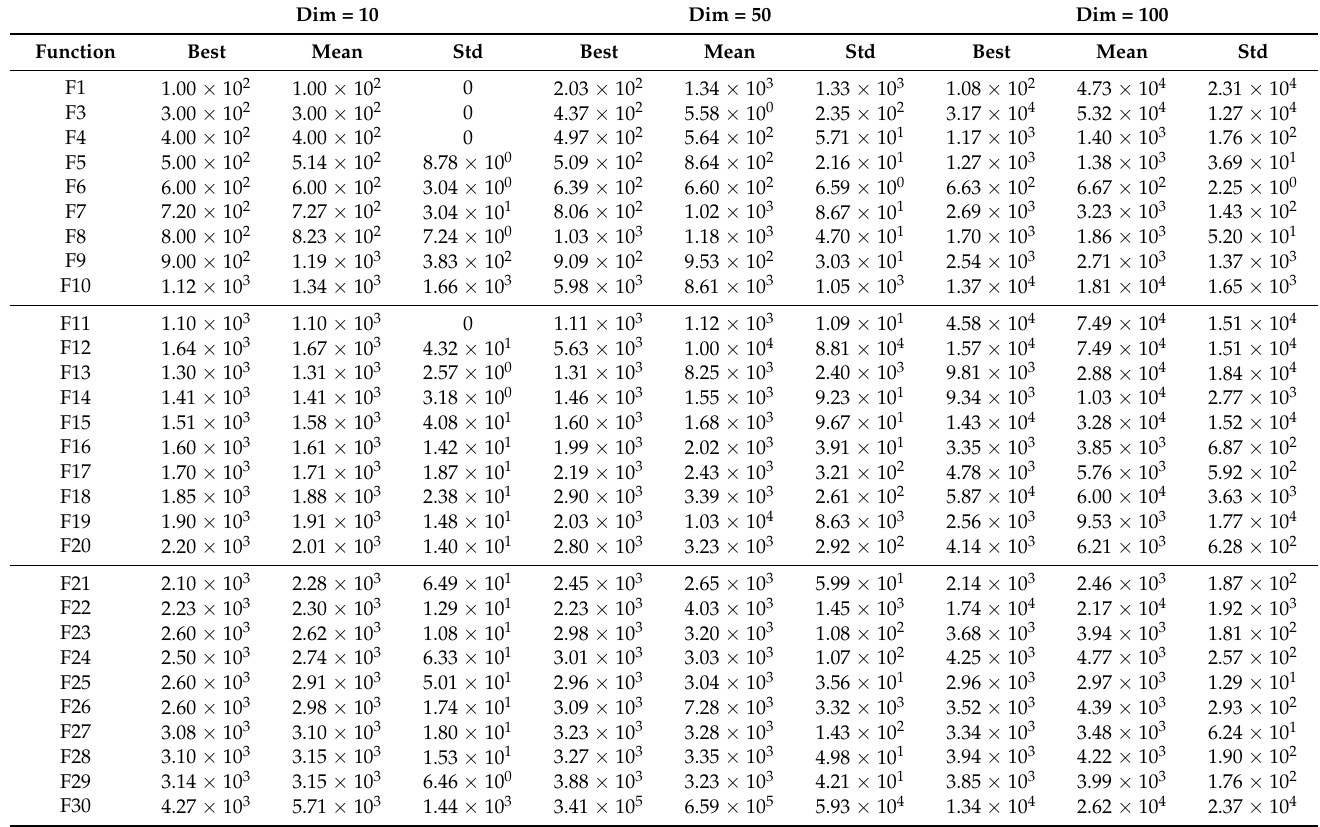
Table 6. The test results of ASDSSA with Dim = 10, Dim = 50 and Dim = 100 on CEC2017. Dim = 10 Dim = 50 Dim =